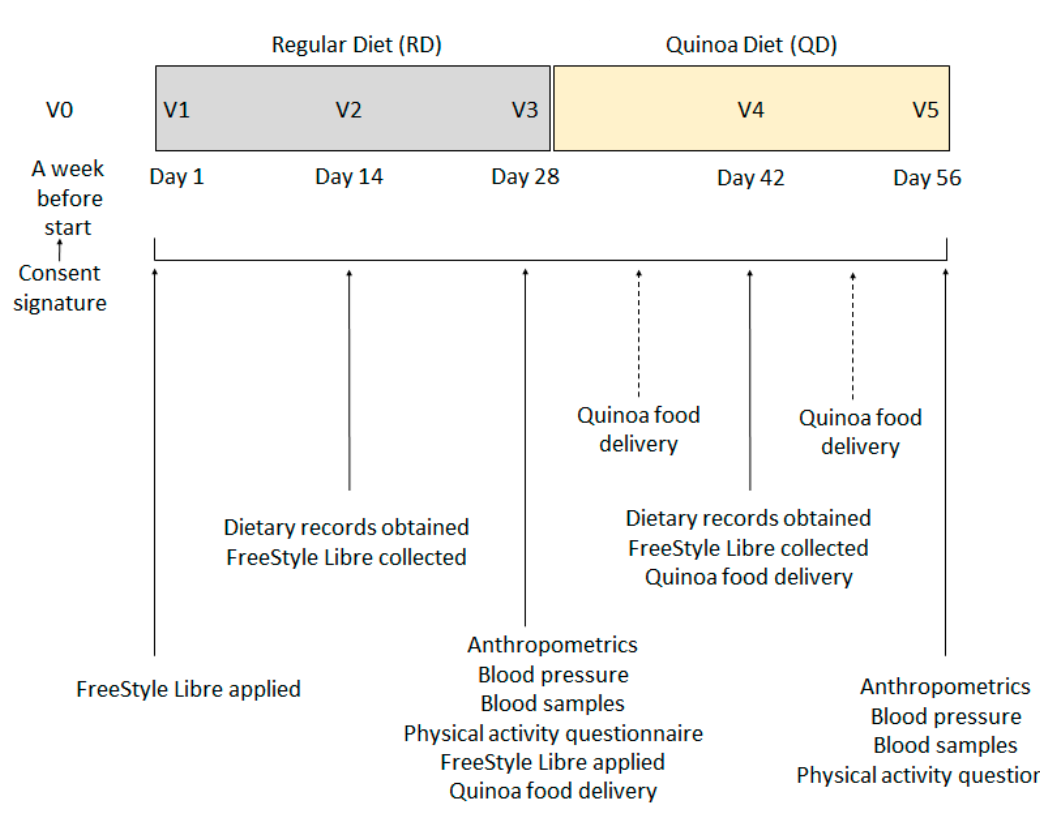
Figure 1. Study design and visits